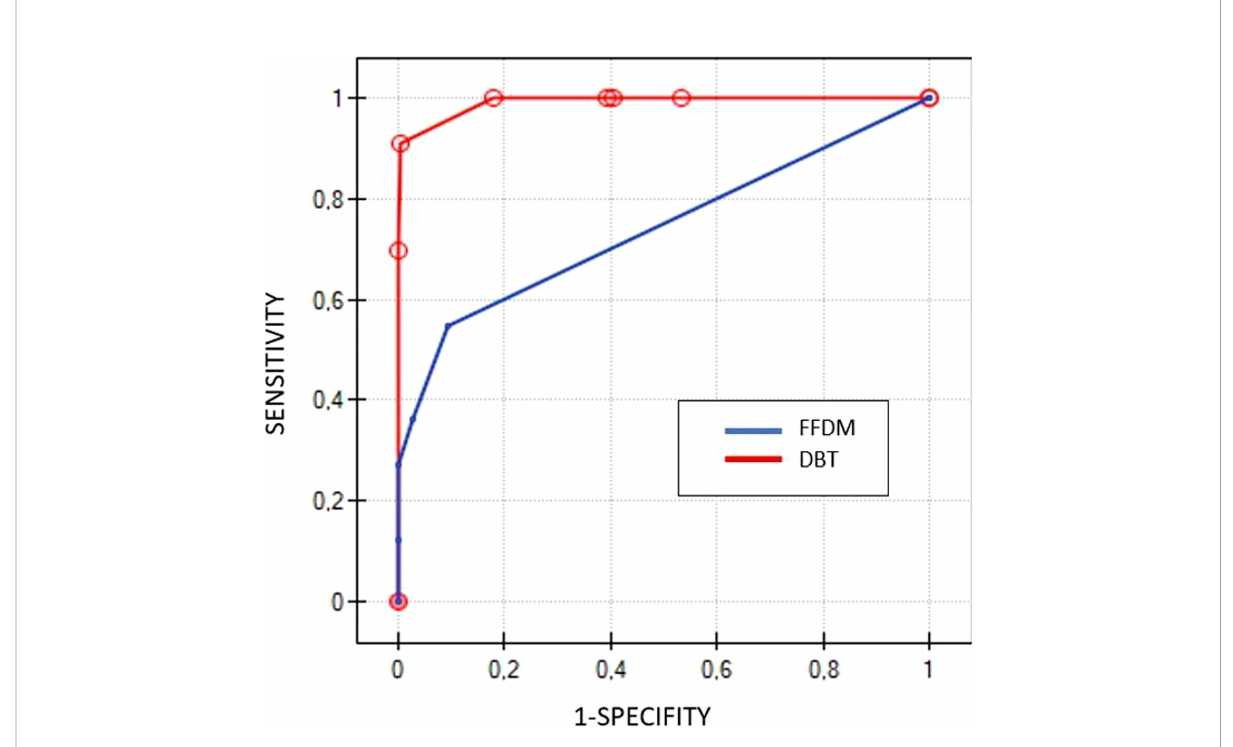
FIGURE 3 Comparison of ROC curves for DBT (red line) and FFDM (blue line) based on BIRADS